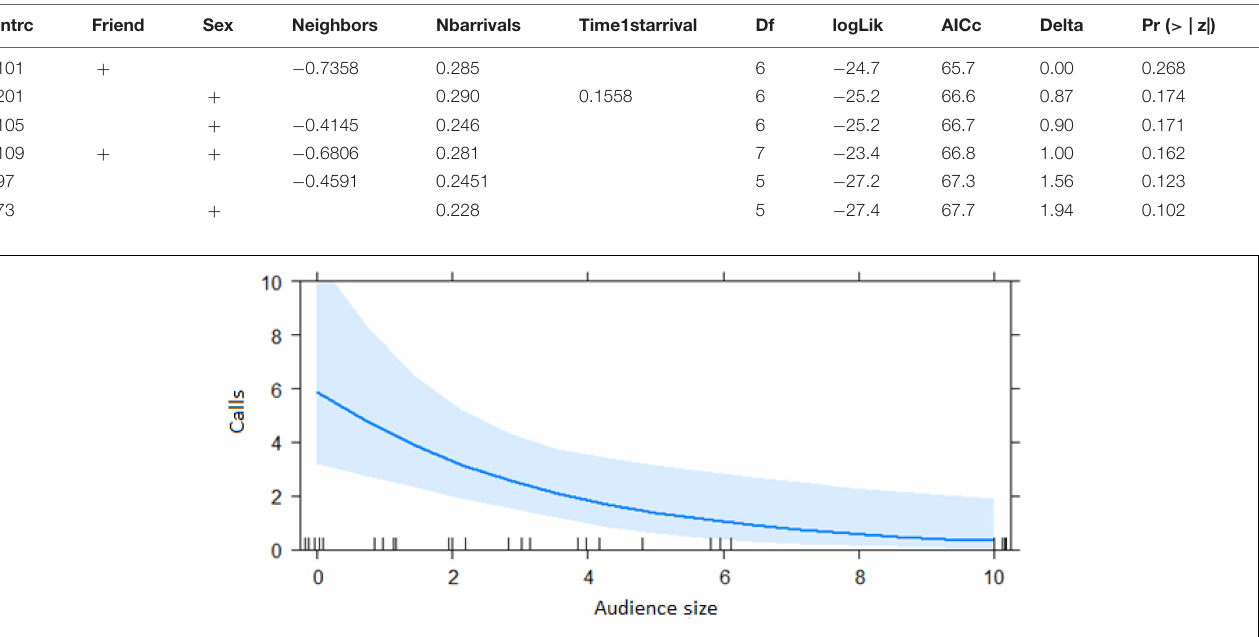
FIGURE 6 | Effect of audience size on the number of alarm calls by ignorant individuals encountering the snake (Audience size = Number of individuals within 10 m of the subject). Calls: Number of alarm calls given by the subject.